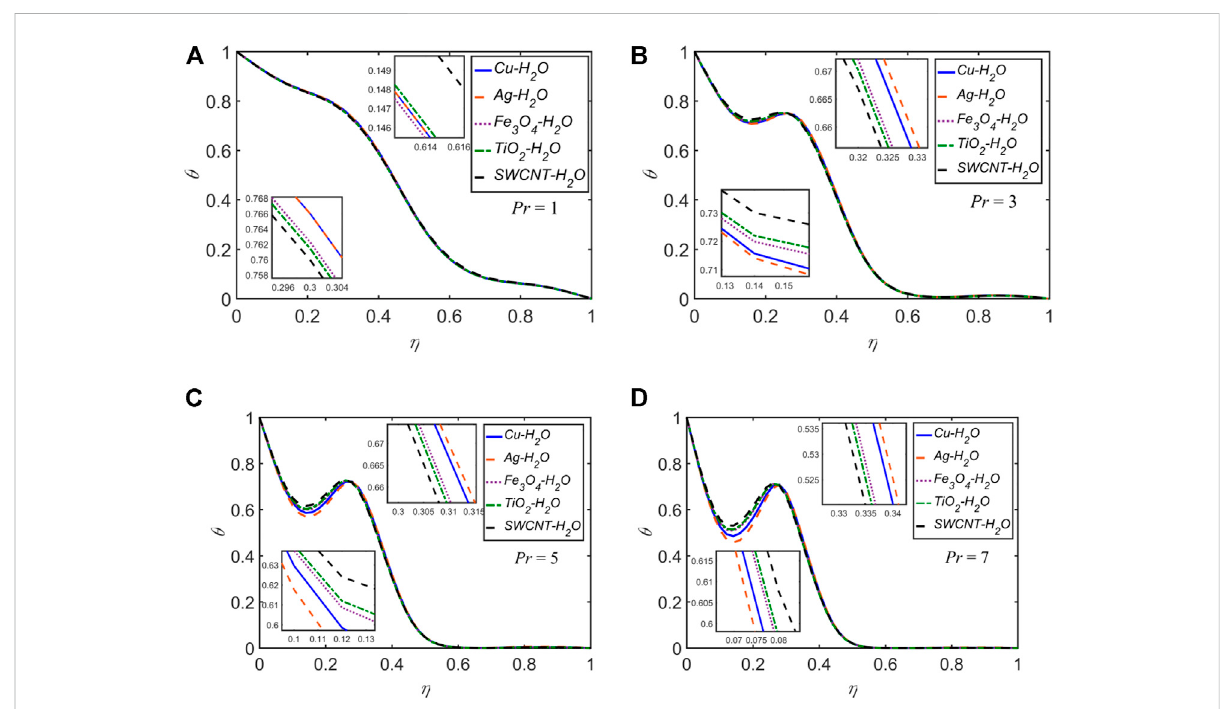
FIGURE 12 The temperature pro fi le θ versus η at x (cid:2) 2 and t (cid:2) 0 . 25 for the fi ve NFs for distinct values of M